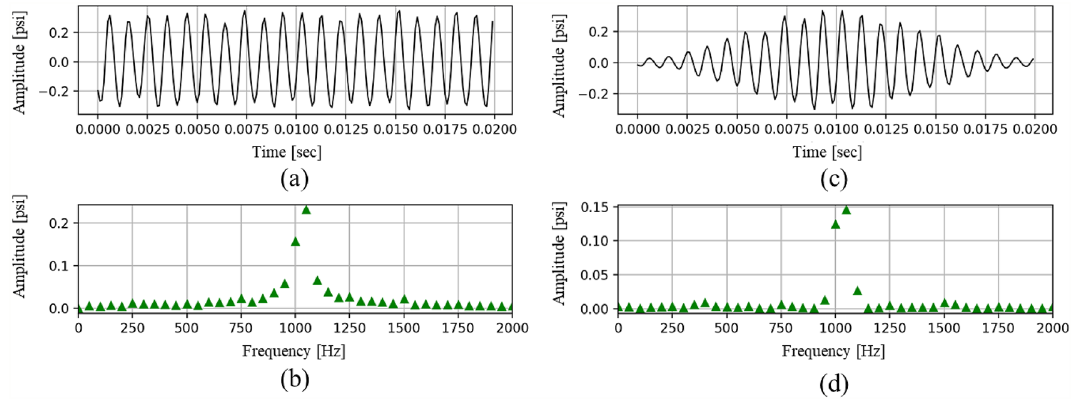
Figure 3. While each row distinguishes the calculation domain as time and frequency, each column represents the DP data before and after a Hamming window. Raw dynamic pressure ( a ) before the Hamming window in the time domain, ( b ) before the Hamming window in the frequency domain (i.e., FFT results), ( c ) after the Hamming window in the time domain, and ( d ) after the Hamming window in the frequency domain (i.e., FFT